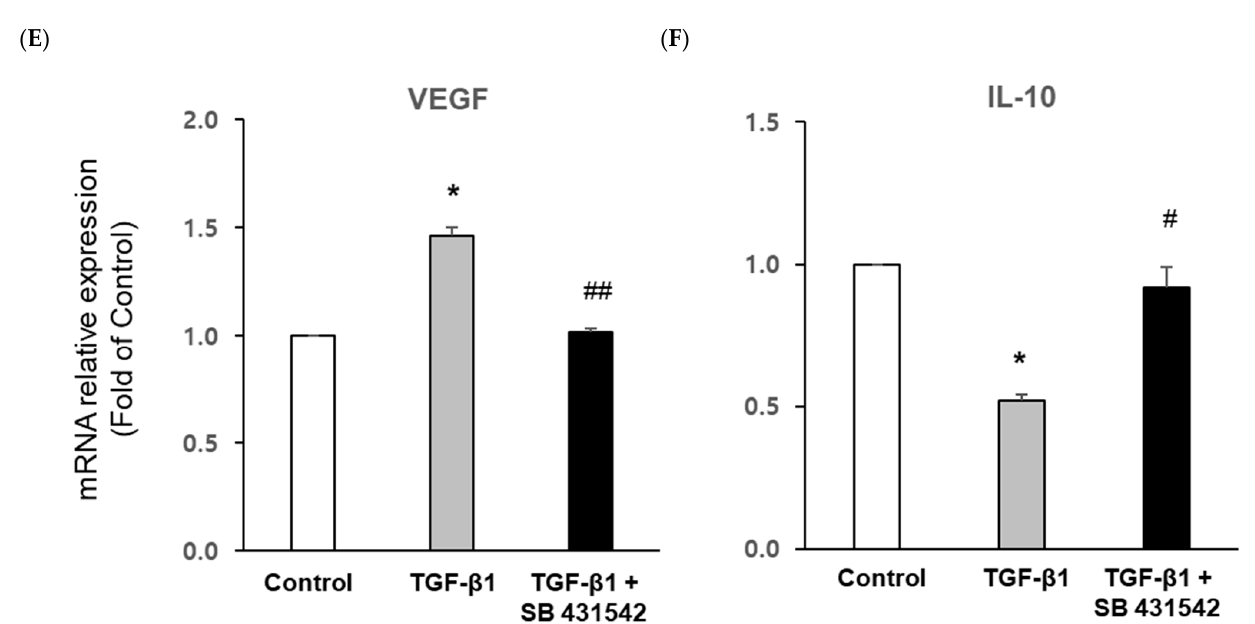
Figure 6. Real-time PCR shows the overall mRNA expression of the 3D chip. Cells were plated at a density of 5 × 10 5 per 3D chip and stimulated with 5 ng/mL TGF- β 1 or 10 µ m inhibitor (SB 431542) for 24 h. Total RNA extracted from the 3D-cultured chip. The mRNA expression of ( A ) IL-1 β , ( B ) TNF- α , ( C ) IL-6, and ( D ) IL-8 represents the anti-inflammatory effect of TGF- β 1 treatment. ( E ) VEGF expression as an angiogenic factor was increased. ( F ) IL-10 expression as an anti-fibrotic factor was significantly decreased by TGF- β 1. * p < 0.05, ** p < 0.01, *** p < 0.001 versus control; # p < 0.05, ## p < 0.01, ### p < 0.001 versus TGF- β 1.